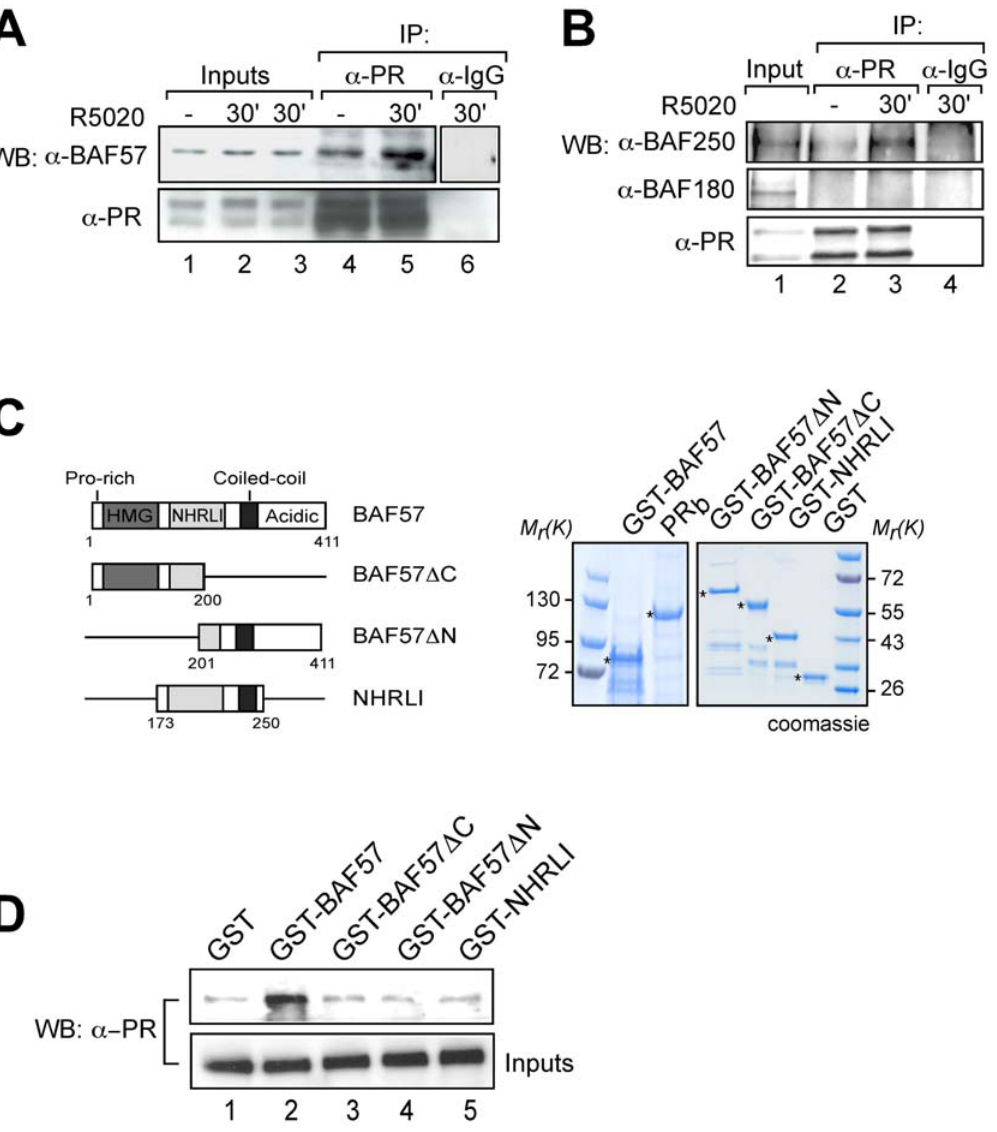
Figure 2. PR forms a complex with BAF in T47D-MTVL cells and binds BAF57 invitro . (A) Cells were untreated ( 2 ) or treated for 30 min with R5020, lysed and immunoprecipitated either with a -PR antibody or with normal rabbit IgG as a negative control (IgG). Inputs and IPs were analyzed by western blot using a -BAF57 and a -PR, as indicated. (B) Cells were treated as in (A). Inputs and IPs were analyzed by western blot using a - BAF180, a -BAF250 and a -PR, as indicated. (C) Left: Scheme of wild type GST-BAF57 or GST-BAF57 deletion mutants used for pulldown assays. Right: Coomassie-stained gel with the level of expression of the BAF57-GST fusion proteins. (D) Recombinant PR and either wild type GST-BAF57 or GST- BAF57 deletion mutants were used for pulldown assays. Binding reactions were incubated with glutathione sepharose beads and eluted by boiling in SDS sample buffer. Input and bound material were analyzed by western blot with a -PR.